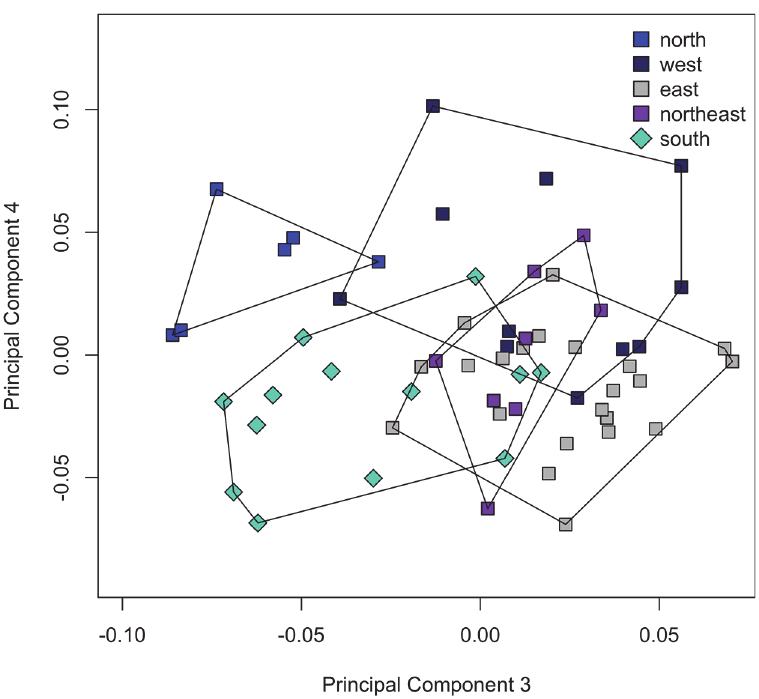
Fig 6. PCA on measurements of S . babaulti and S . pleurospilus . PC4 vs. PC3 of a PCA on the 20 measurements belonging to four geographical groups of S . babaulti and to S . pleurospilus (the southern group).